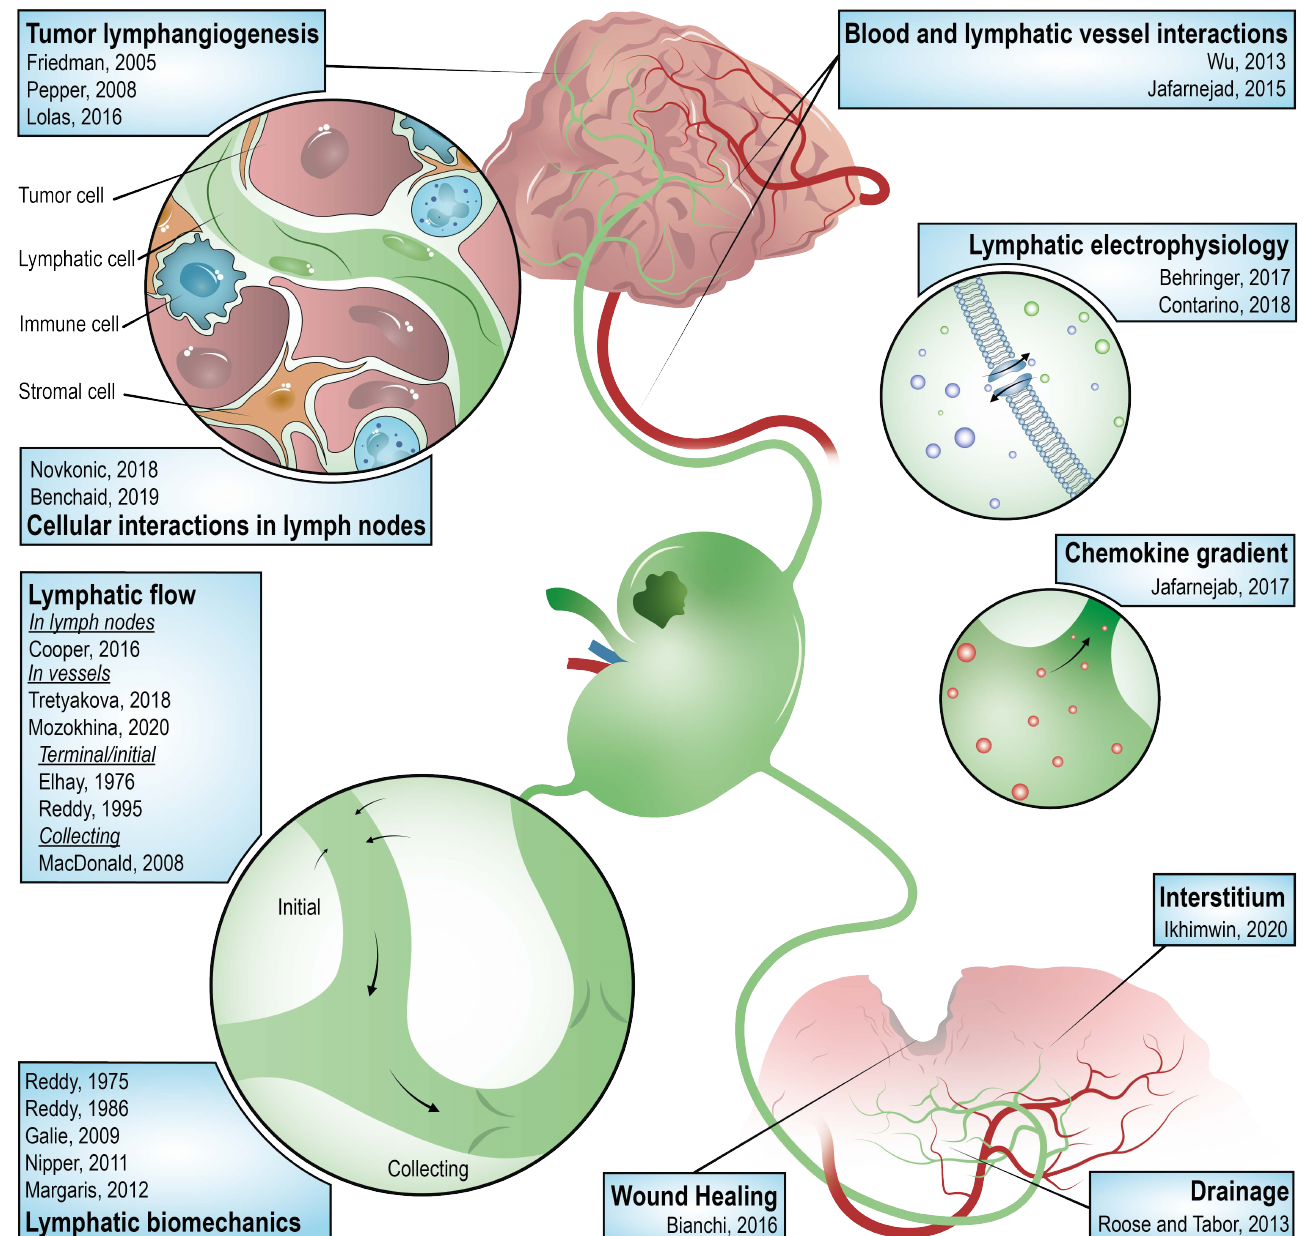
Figure 4. Summary of the in silico models developed in the context of the lymphatic system and the process of lymphangiogenesis. In the context of lymphatics, in silico models of lymphatic flow, drainage, and biomechanics were first developed. Tumor lymphangiogenesis was then studied with hybrid multiscale computational approaches, as well as the interactions between different populations of cells (tumoral, lymphatic, immune, and stromal cells). The effects of a permeable interstitium and a chemokine gradient on the lymphatic network were investigated through in silico techniques. Blood and lymphatic vessel interactions were studied with hybrid mathemati- cal models. The well-known equations of Hodgkin–Huxley were used to mathematically inves- tigate lymphatic electrophysiology. Skin wound healing was lastly modeled and studied with differential equations